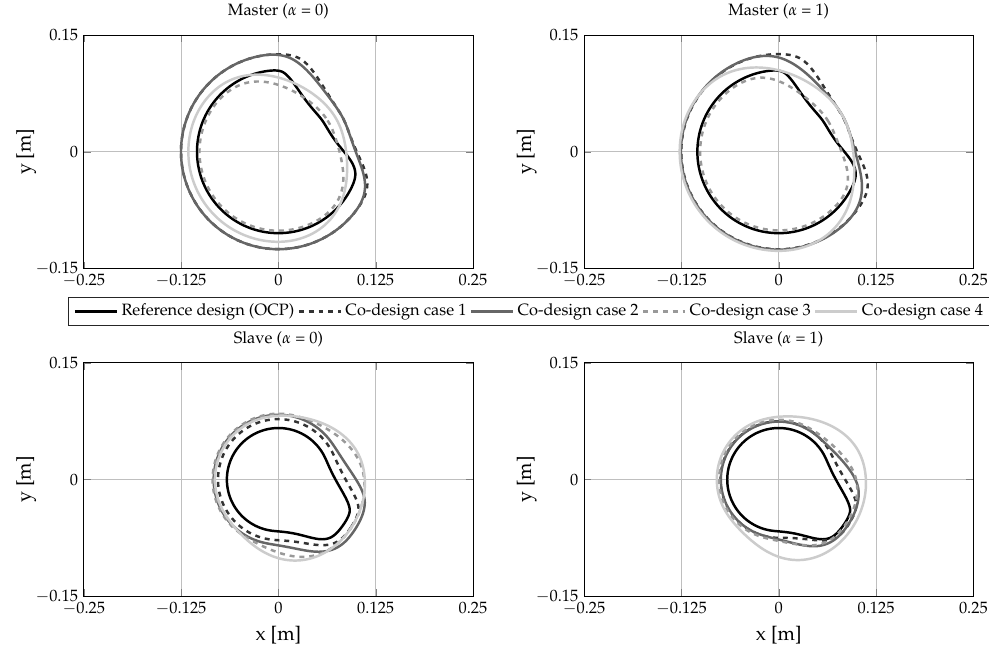
Figure 16. The resulting cam shapes for the master and follower cams for the reference design (OCP) and the four co-design cases for α =